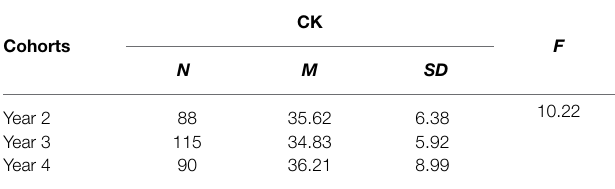
TABLE 1 | Comparison among three preservice teacher cohorts’ content knowledge (CK) scores.